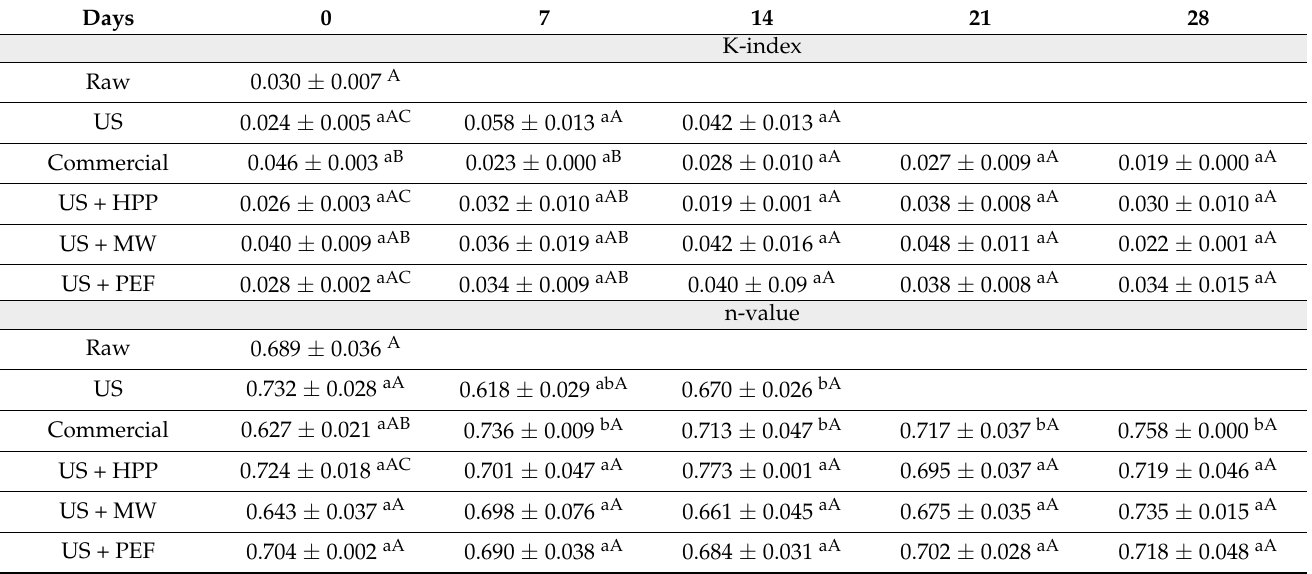
Table 2. Values of consistency coefficient ( K ) and the flow behavior index ( n ) were obtained after fitting the flow curves to the Power Law model for each treated milk during the shelf life. For all of the results, the R 2 ranged from 0.97 to